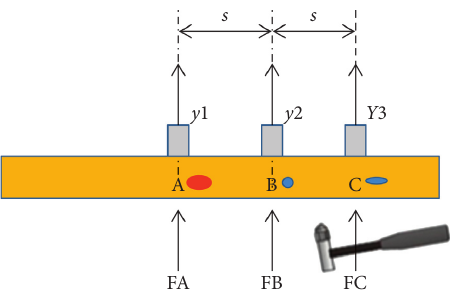
Figure 6: T-block method for angular acceleration measurement.